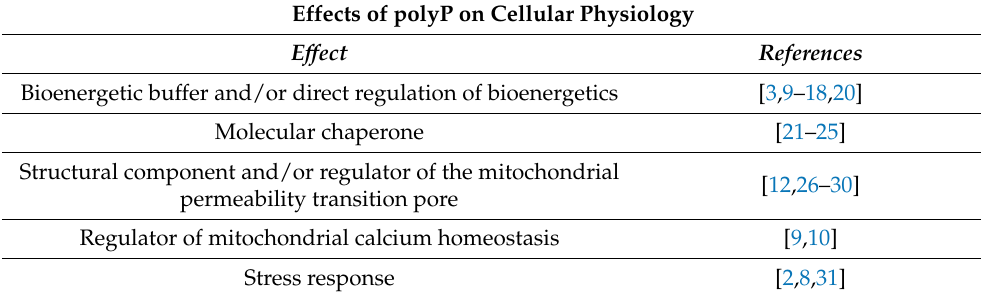
Table 1. Effects of polyP on cellular physiology. Schematic representation containing some of the main described effects of polyP on cellular physiology. Many of these affects are closely related to the status of cellular bioenergetics in mammalian